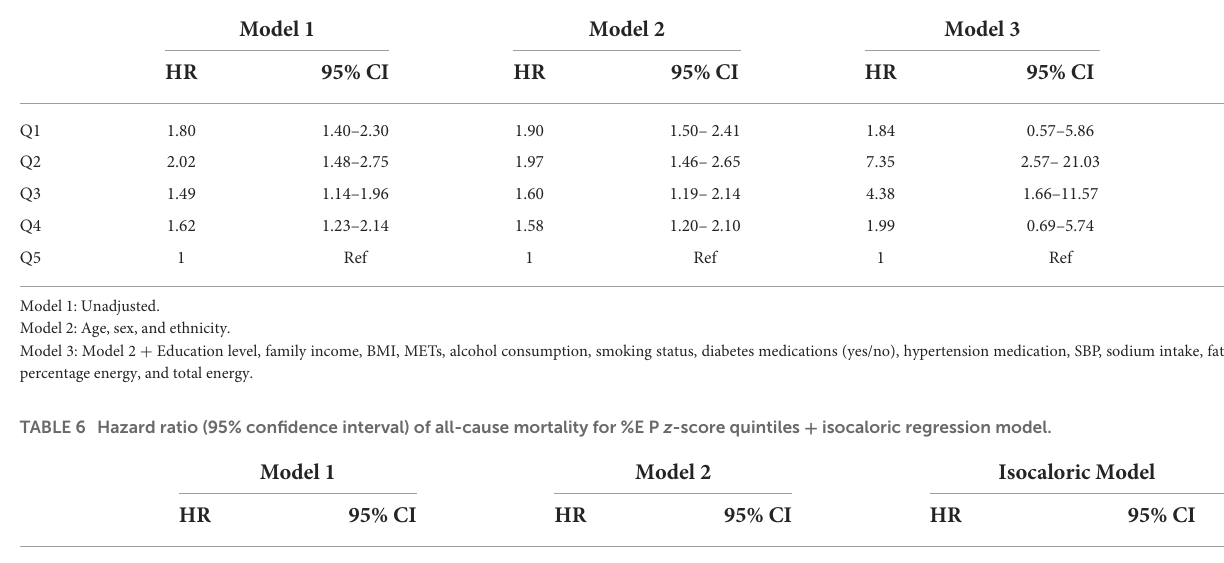
TABLE 5 Hazard ratio (95% confidence interval) of all-cause mortality for %E P:C z -score quintiles.